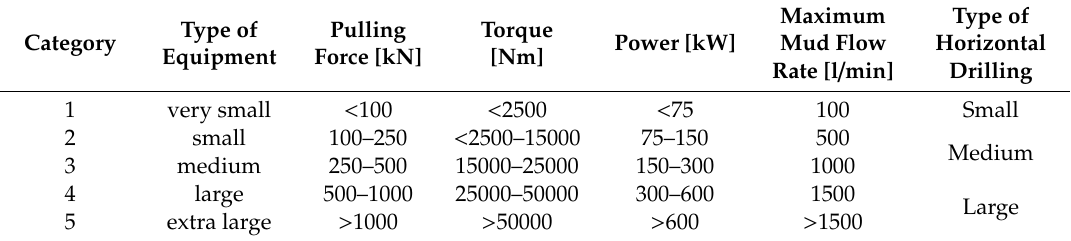
Table 1. Horizontal Directional Drilling (HDD) equipment categories